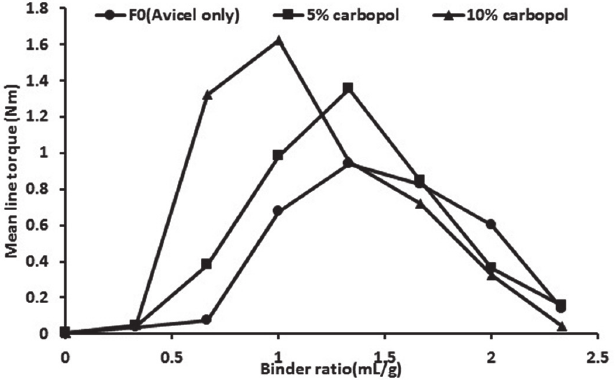
FIGURE 3 - Effect of different concentrations of Carbopol on mean torque of Avicel PH101 ® wet